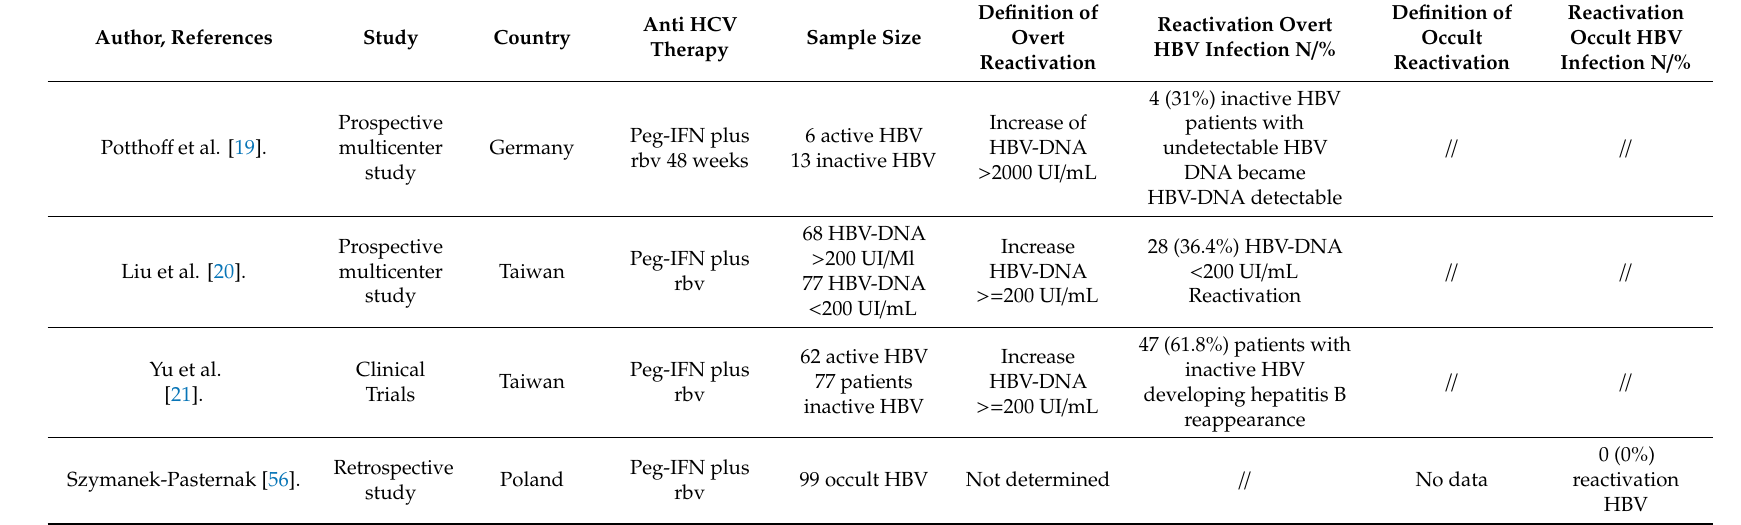
Table 1. Studies evaluating hepatitis B virus (HBV) reactivation in anti-hepatitis C virus (HCV)-positive patients treated with Interferon-based